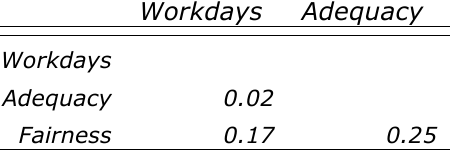
Table A 4. Response variable correlations calculated using restricted maximum likelihood.